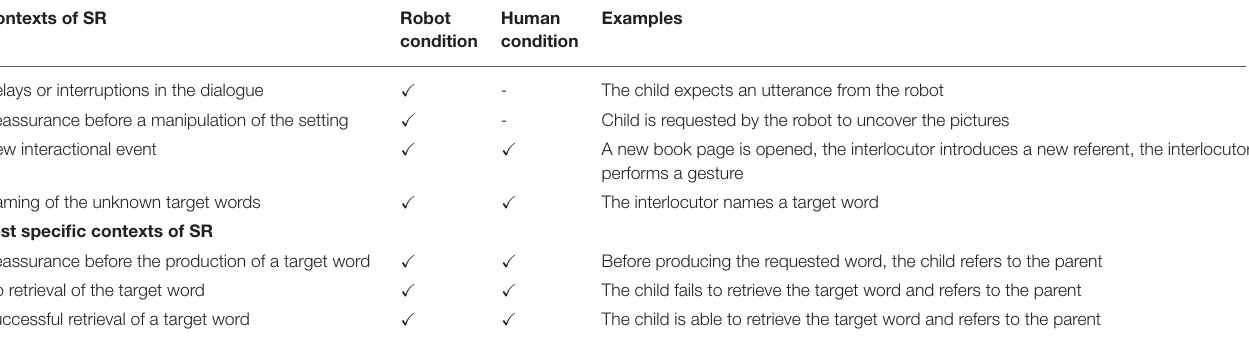
TABLE 1 | Interactional contexts of children’s social referencing (SR). Contexts of